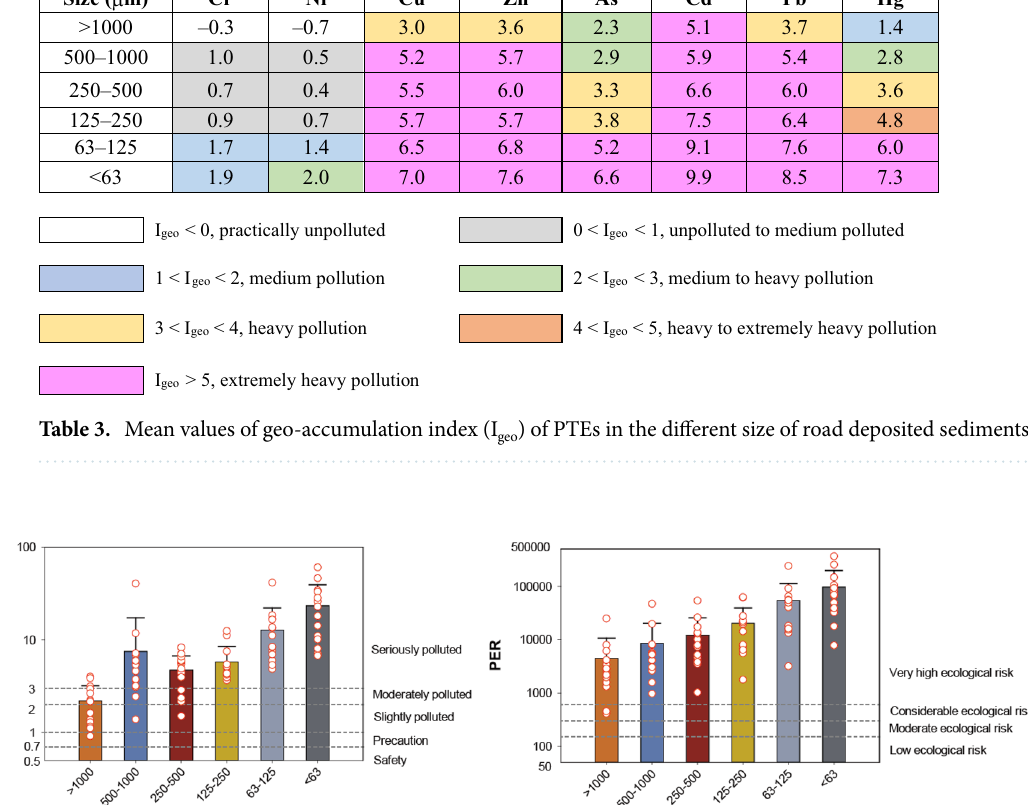
brush sweeper is more efficient than a vacuum sweeper for large sediments in the road, but the vacuum sweeper can be effective in removing fine particles. Kim et al. 67 estimated the removal efficiency of RDS by sweeping with vacuum-assisted rotary brush sweeper in Korea. They found that the mean of reduction in the load of RDS and heavy metals of highway by sweeping was 61.1% and 48%, respectively. The removal of particles (> 63 μm) is greatly improving the highway runoff quality by vacuum-related rotary brush sweeper of RDS, indicating that the sweeping is more efficient for large particles. Given the total length of entire road, the amount of RDS and PTEs concentrations on the road surface, huge amounts of PTEs can be accumulated in the RDS of the industrial area. RDS had the highest concentrations of PTEs in fine particles that are difficult to remove by road sweep- ing. In Korea, RDS is periodically removed by various types of road cleaning vehicles in urban cities, but road cleaning is not performed in industrial areas. Our results show that road cleaning in industrial areas can